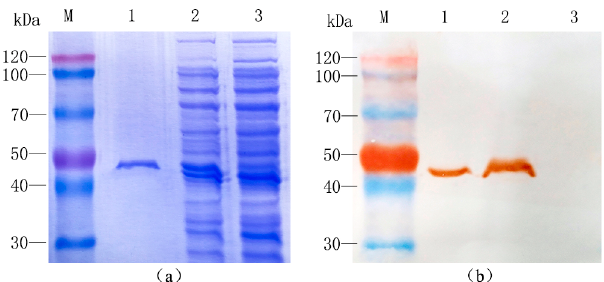
Figure 3. Identification of recombinant TwSQS protein. ( a ) SDS-PAGE detection of recombinant TwSQS protein expressed in E. coli Transetta (DE3); ( b ) Western Blot assay of the recombinant TwSQS protein expressed in E. coli Transetta (DE3). M: protein marker. Lane 1: purified protein of induced pET30a-TwSQS bacteria; Lane 2: supernatant of induced pET30a-TwSQS bacteria; Lane 3: supernatant